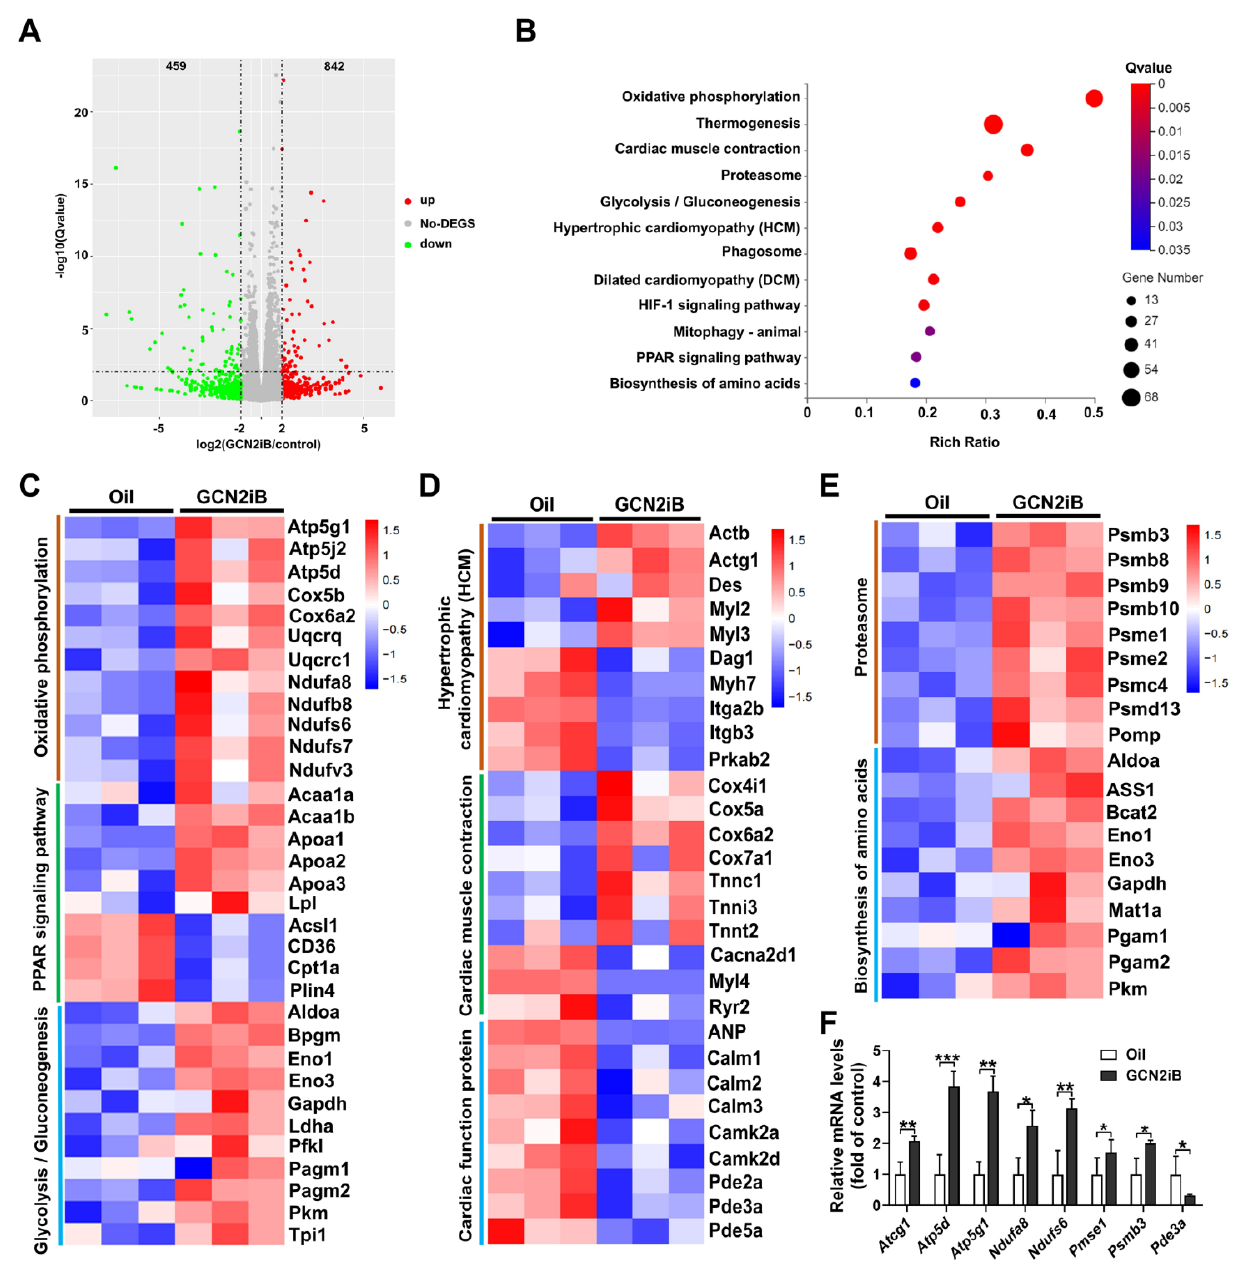
Figure 3. GCN2iB affects gene expression profiles in T2D mice. ( A ) A volcano plot was used to show the fold changes in differentially expressed genes (DEGs) in the control group vs. the GCN2iB group. ( B ) Twelve significantly enriched KEGG pathways are listed as an advanced bubble chart. ( C ) The gene expression profiles of the DEGs that were involved in oxidative phosphorylation, the PPAR signaling pathway and glycolysis/gluconeogenesis pathways are shown in the heatmap. ( D , E ) The gene expression profiles of the DEGs that were involved in cardiac function, proteasome and biosynthesis of amino acids pathways are shown in the heatmap. ( F ) The mRNA levels of some randomly selected differentially expressed genes were measured by qPCR. In Figure f, N = 5, values are expressed as the means ± SD; * indicates p < 0.05; ** indicates p < 0.01; *** indicates p < 0.001.